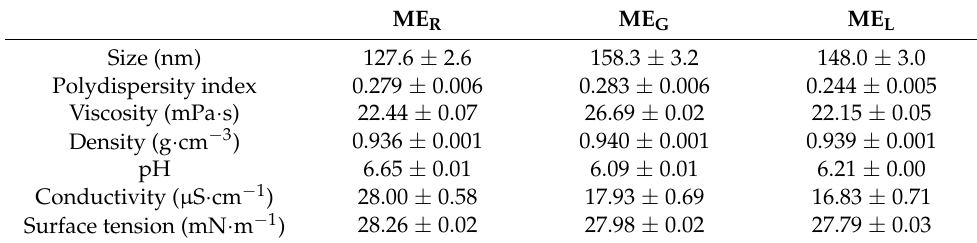
Table 2. The Basic Physical Parameters of the Microemulsions.